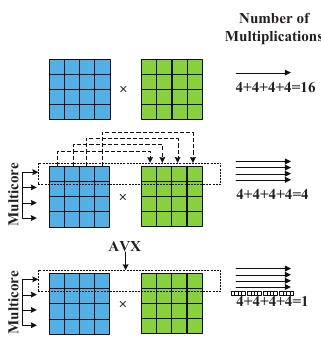
Figure 10. Parallel phase multiplication with OpenMP and